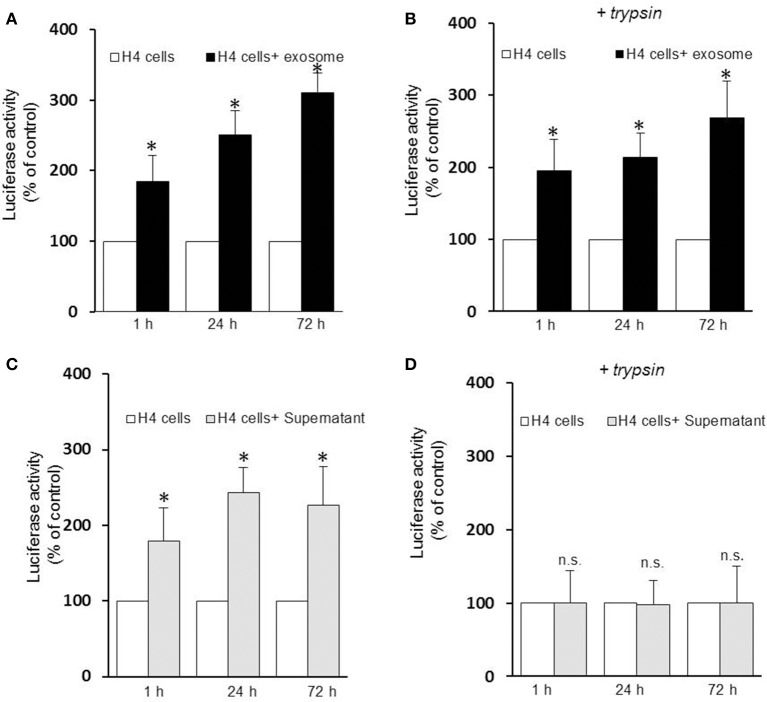
Exosomes-associated αsyn oligomers are preferentially internalized by H4 cells. Exosomes-associated αsyn oligomers bind to the cell membrane of recipient cell (A), and get internalized (B) in a time dependent manner as seen by a significant increase of luciferase activity over time (*p < 0.05 as compared to control). (C) Free αsyn oligomers bind to the H4 recipient cells membrane but are not internalized (D), trypisinization of the cell abolishes completely the luciferase signal observed previously (p > 0.0.05). Data are given as mean ± S.E.M., from three independent experiments. Statistical analysis was performed with one-way ANOVA, followed by Tukey HSD Multiple Comparison test; n.s, not significant.